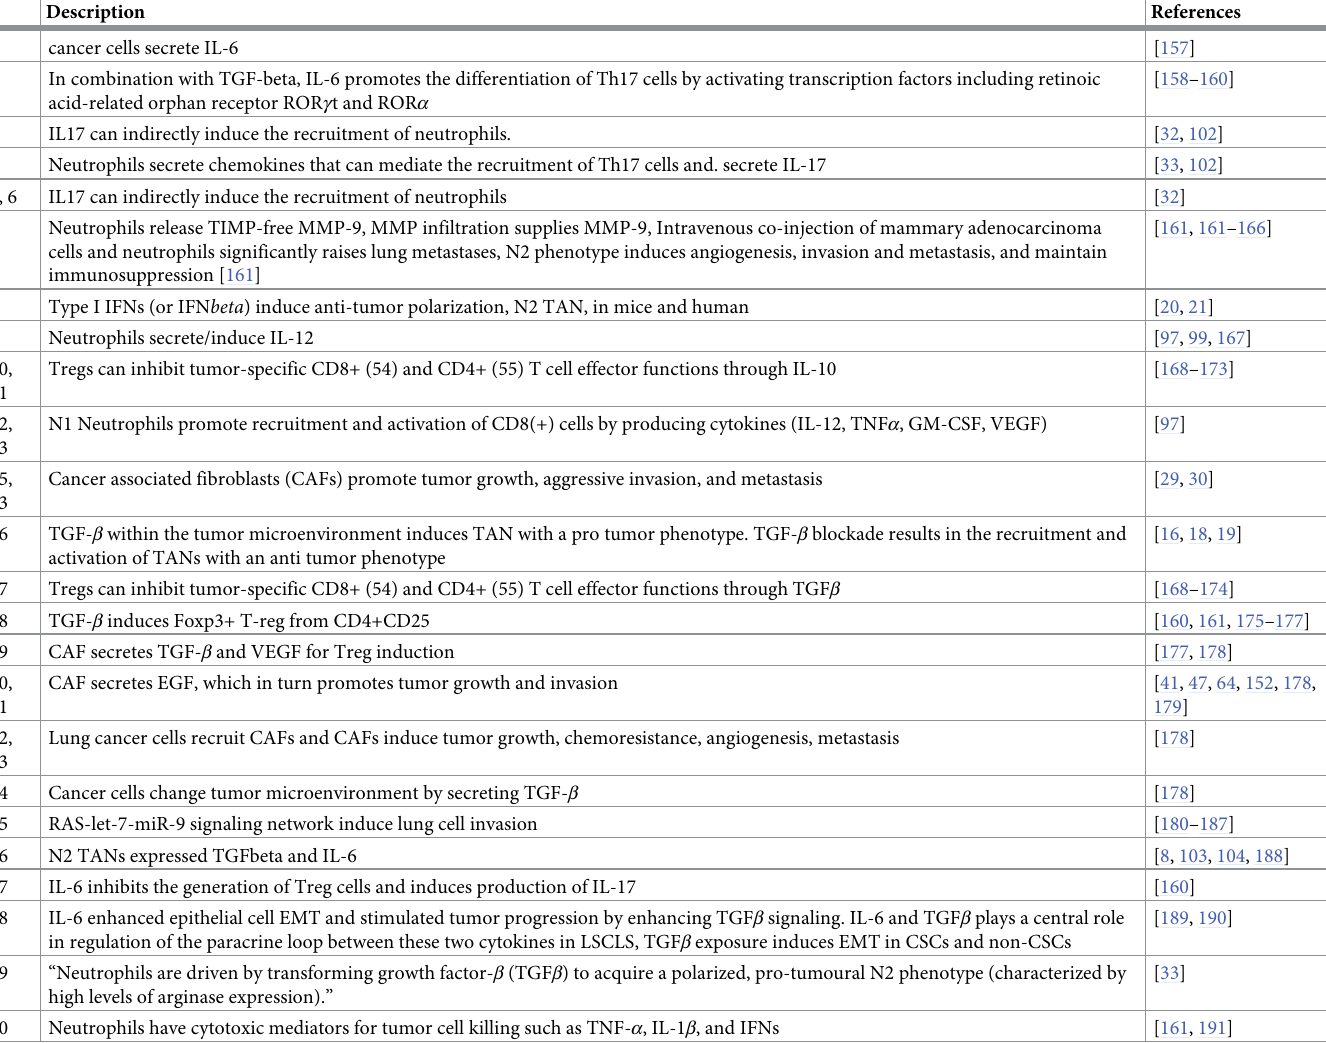
Table 1. Summary of interaction networks (Fig 1) in invasion processes in lung cancer